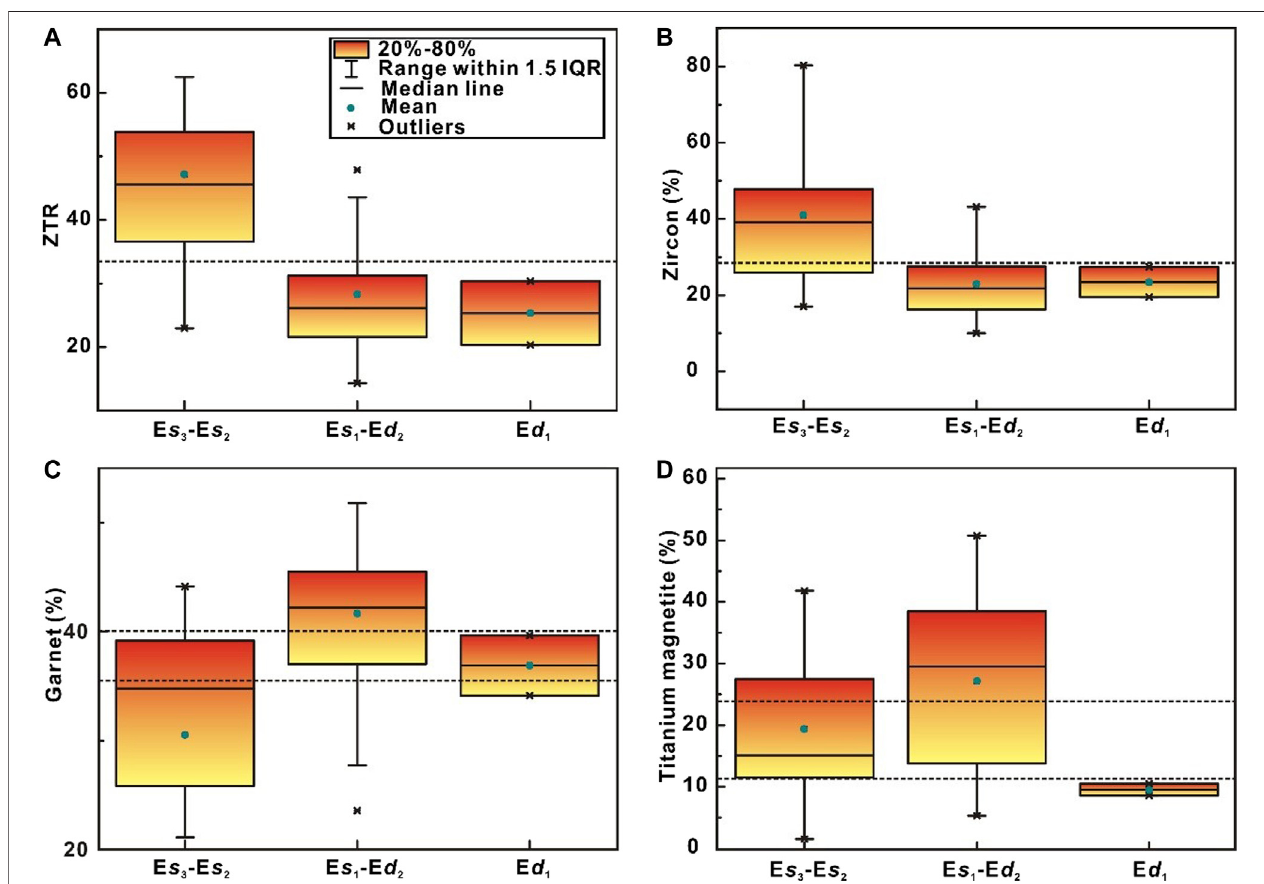
FIGURE 3 | The box-plots of (A) ZTR index, the contents of (B) zircon, (C) garnet, and (D) titanium magnetite of different intervals of the Paleogene in Nanpu Sag.